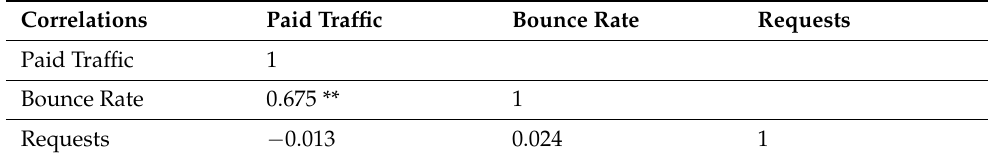
Table 7. Coefficients between the examined metrics for H3.